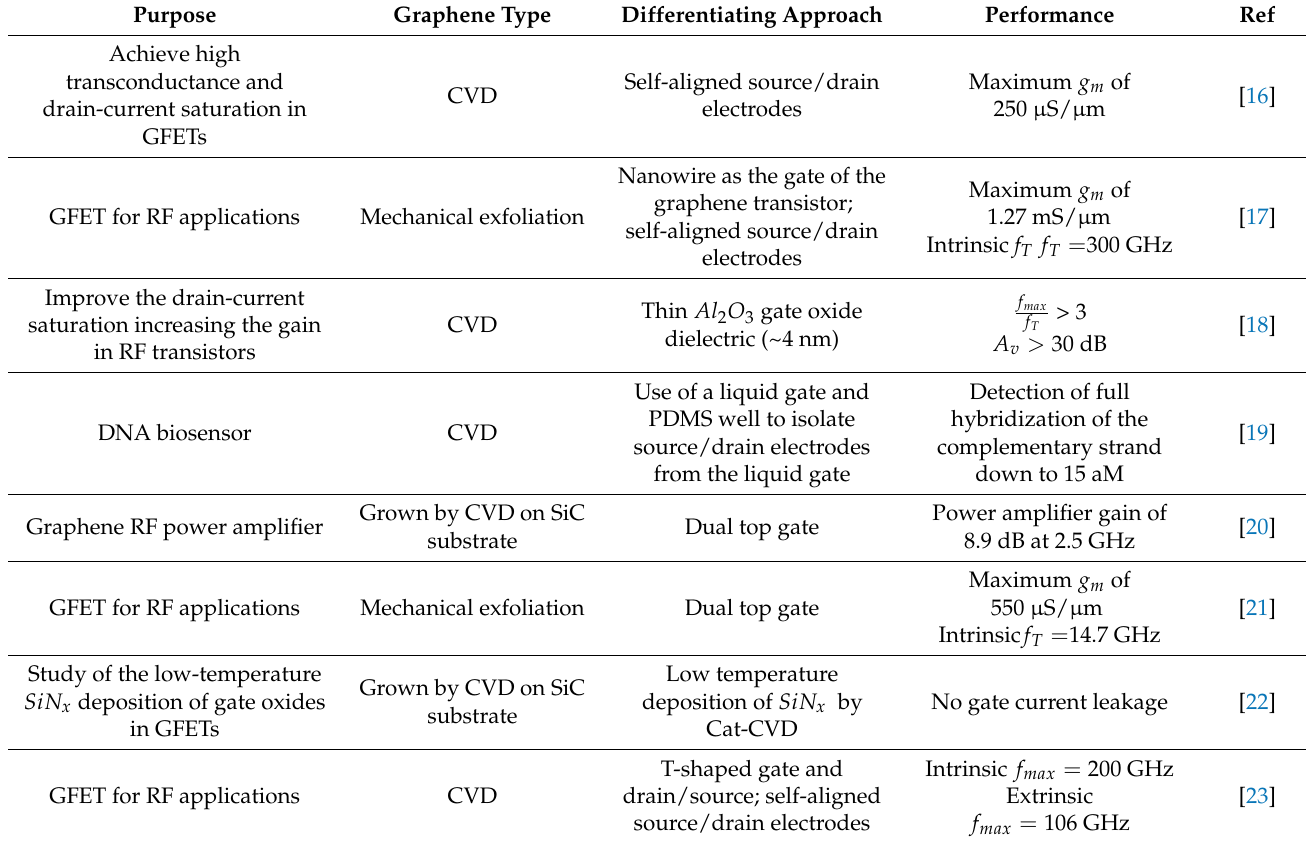
Table 1. Top-gated graphene